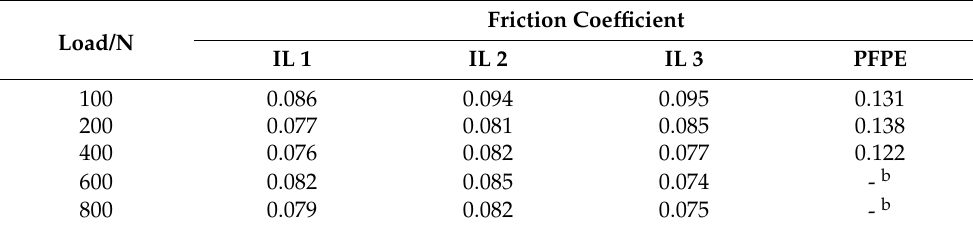
Friction Coefficient